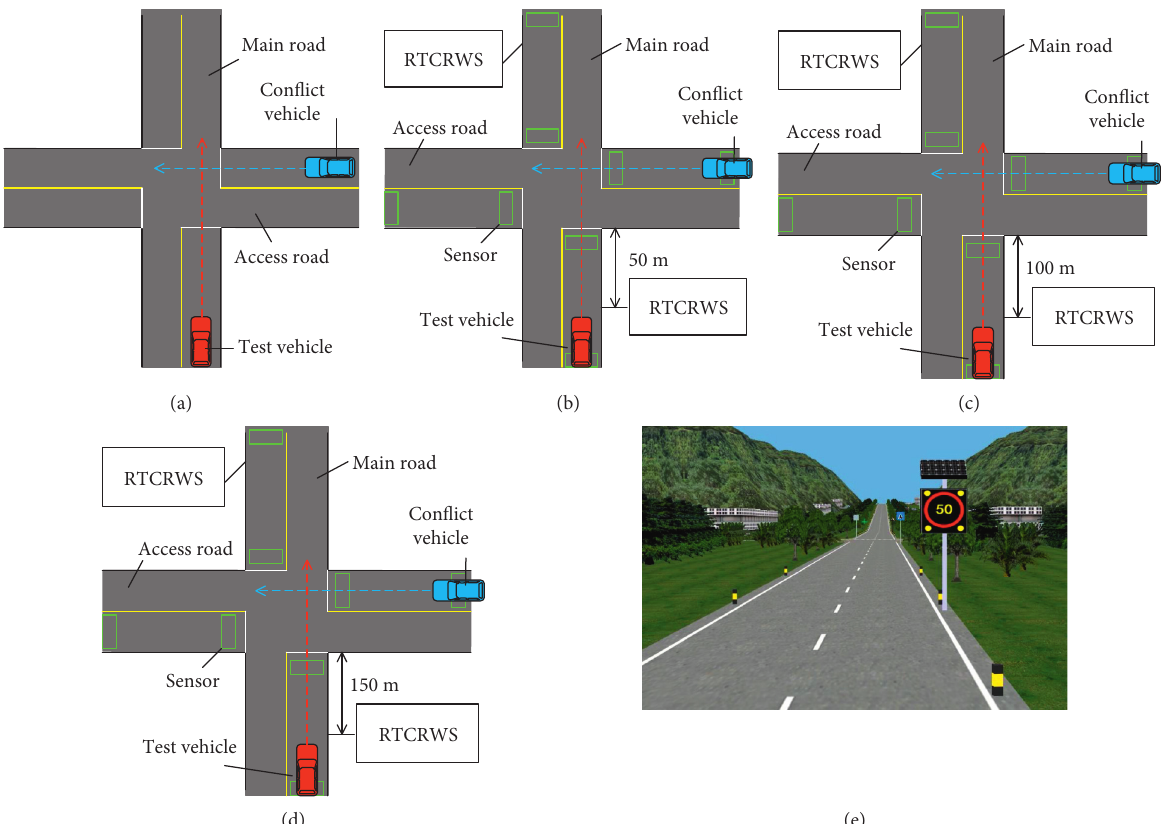
Figure 3: Schemes location of RTCRWS. (a)Scheme 1. (b)Scheme 2. (c)Scheme 3 (d)Scheme 4. (e)Schematic diagram of RTCRWS experimental location.